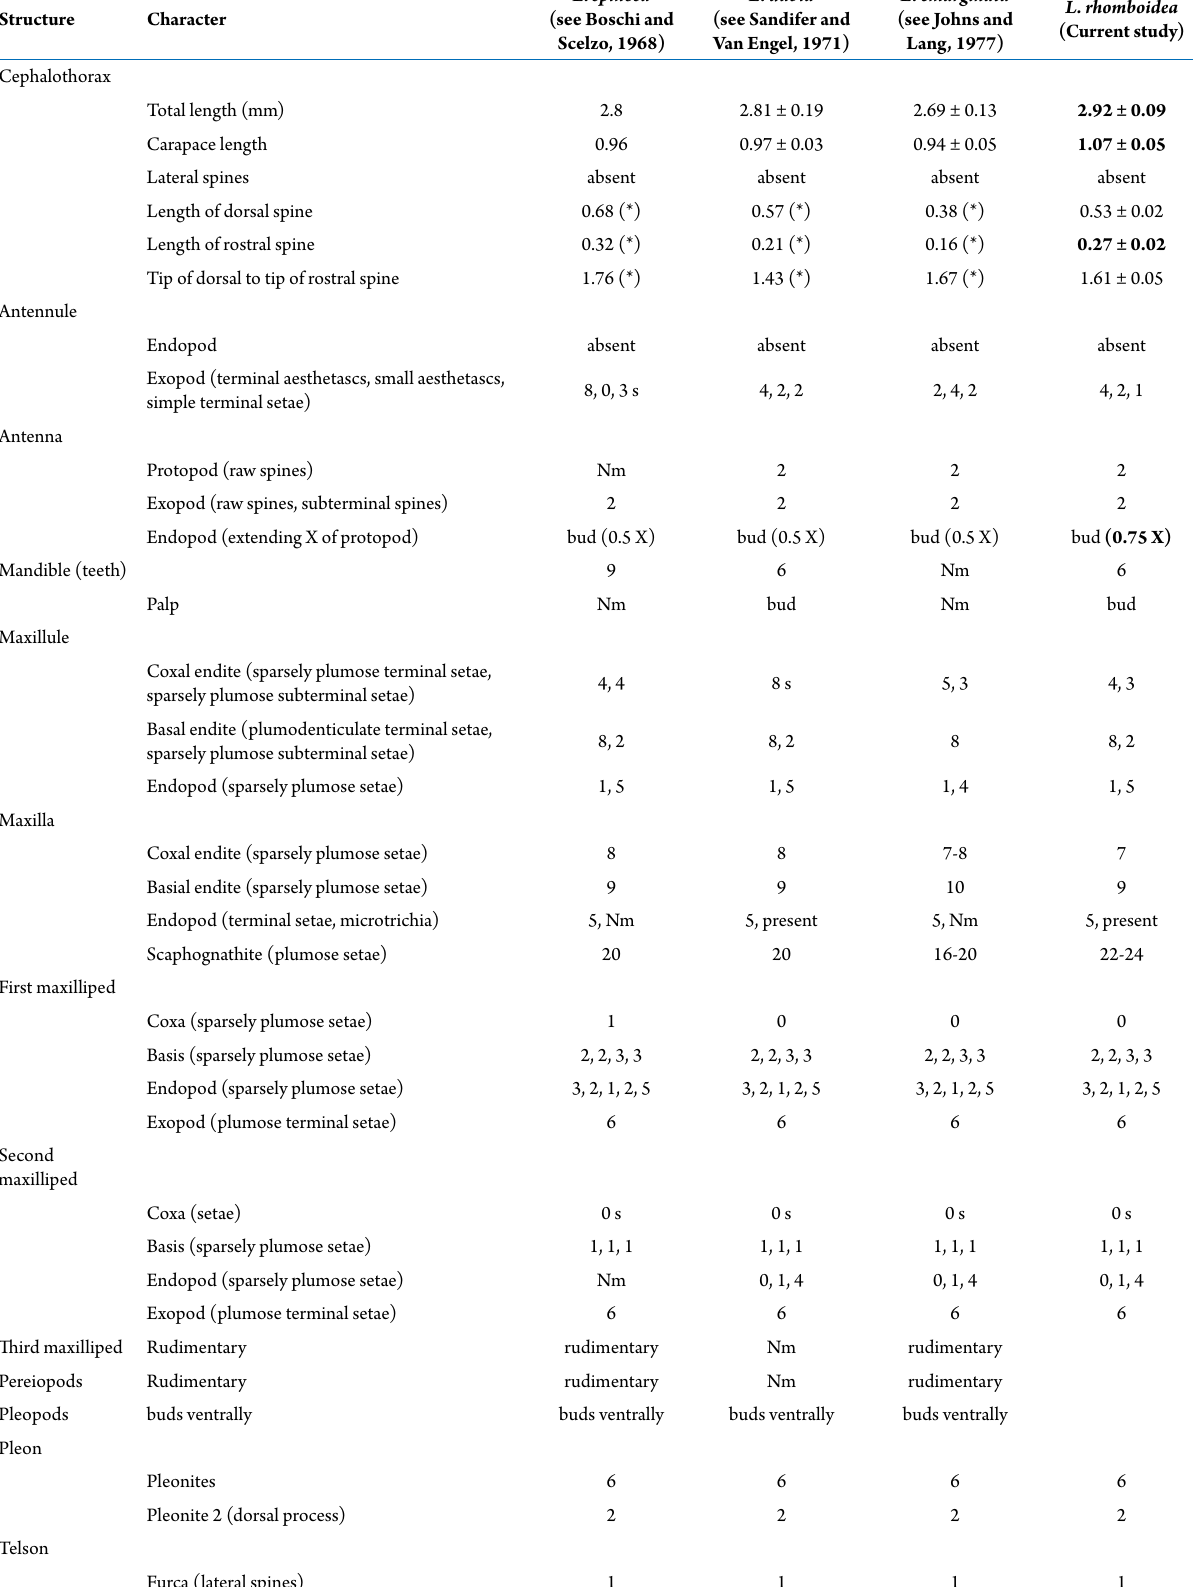
Table 2. Second zoea of Libinia spp. Character comparison of four species. Nm, not mentioned; (*) obtained from the figure. Bold type indicates observed